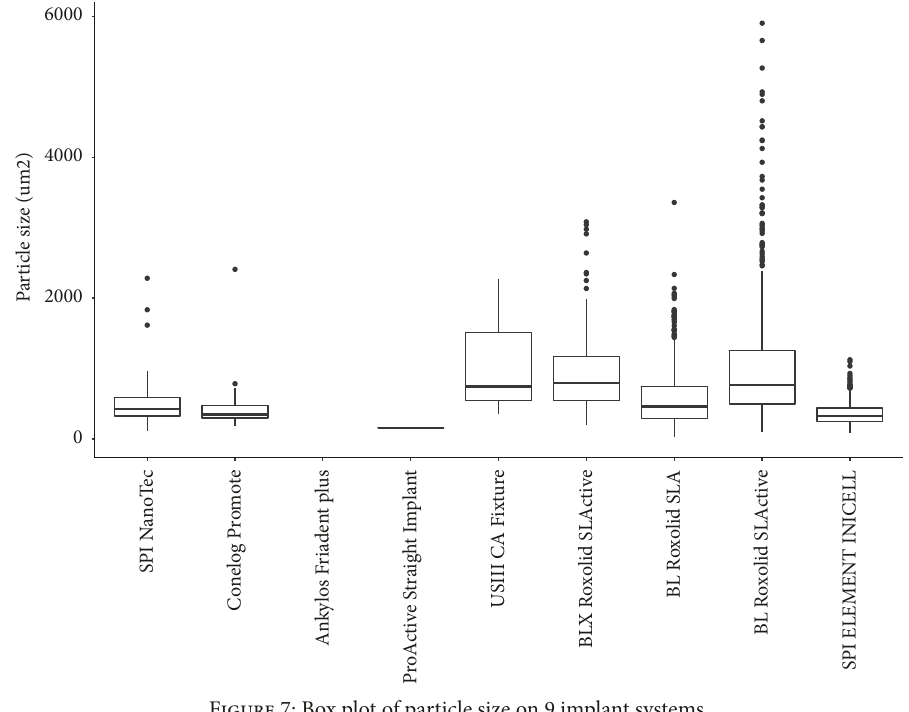
Figure 7: Box plot of particle size on 9 implant systems.